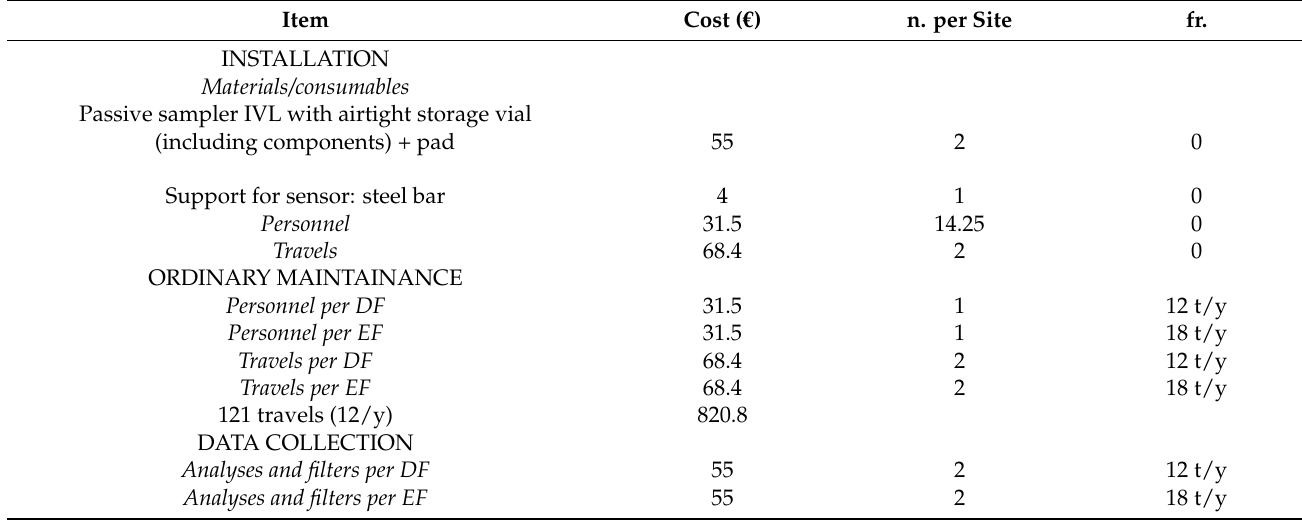
Table 6. Total cost of passive monitoring station items with IVL sensors, listed separately per installation, ordinary maintenance, and data collection for deciduous forests (DF) and evergreen Mediterranean forests (EF). Extraordinary maintenance is not